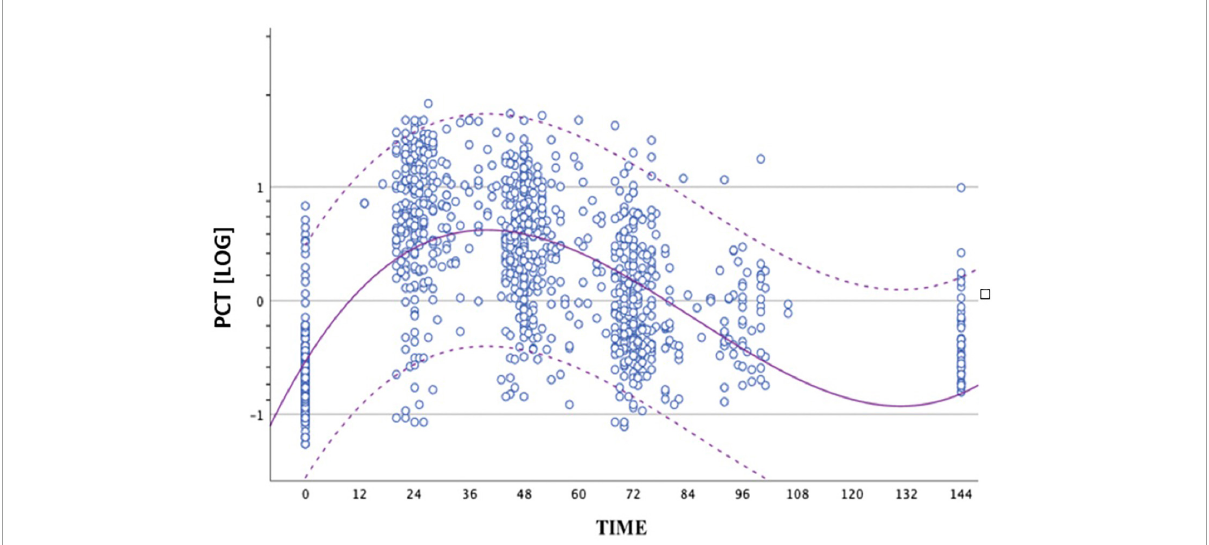
FIGURE1 Distribution of PCT values obtained from the group of non-septic newborns between birth and 72 ± 4 h of life. The circles represent the logPCT values. The dashed curves represent the upper and lower limits of the reference range. The continuous curve represents the geometric mean. The logarithmic scale of the PCT values is shown on the ordinate